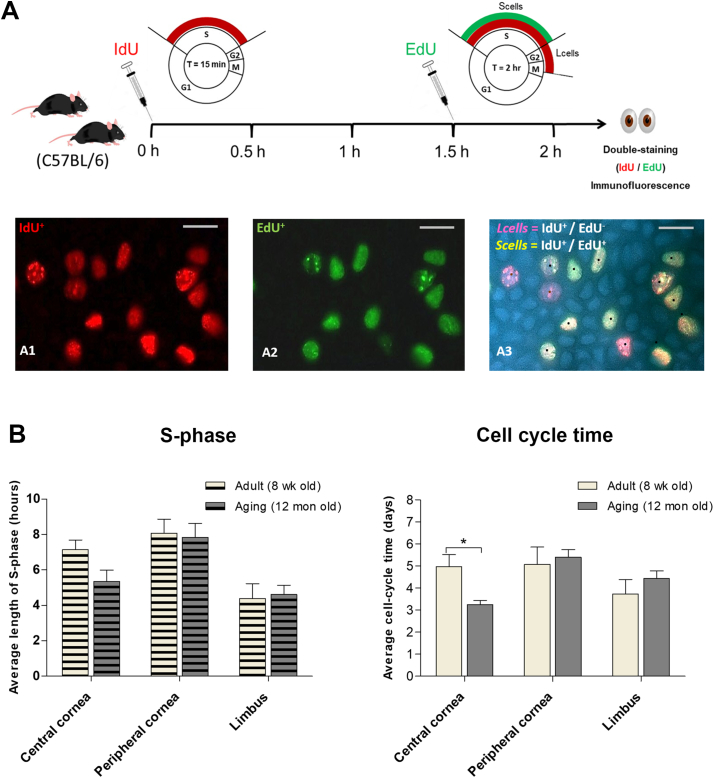
Cell cycle kinetics in corneal and limbal epithelia of mice. (A) Methodological scheme illustrating the 1.5-h interval between IdU and EdU injections in vivo. IdU-labelled cells red (A1), EdU-labelled green (A2). The red-only cells in (A3) marked with brown dots represent the Lcells. The red and green double-labelled cells in (A3) represent the Scells. Scale bars = 10 μm. (B) Average S-phase (Ts) and cell cycle time (Tc) (mean ± SEM) in epithelia of central cornea, peripheral cornea and limbus of 8 week and 12 month-old C57BL/6 mice. P < 0.05 (t-test; n = 6) is shown by the asterisk (*). (For interpretation of the references to colour in this figure legend, the reader is referred to the web version of this article.)